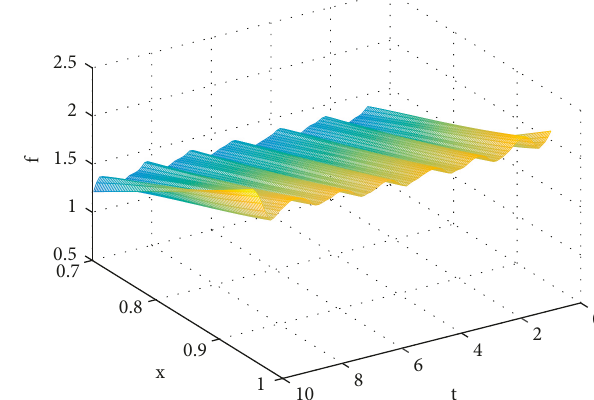
Figure 13: The change of spring